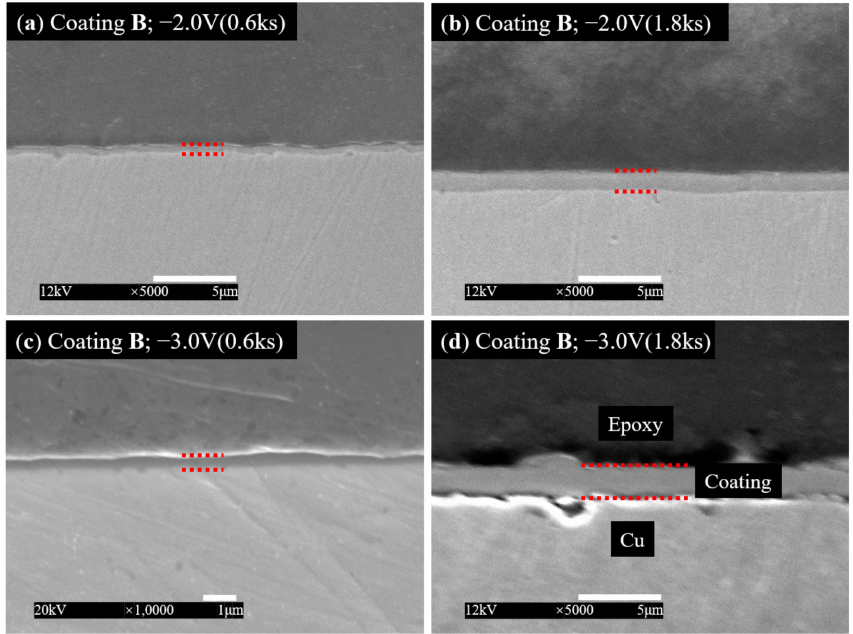
Figure 4. Cross-section of coating B deposited at − 2.0 V ( a , b ) and − 3.0 V (vs. SSE) ( c , d ) for 0.6 ks and 1.8